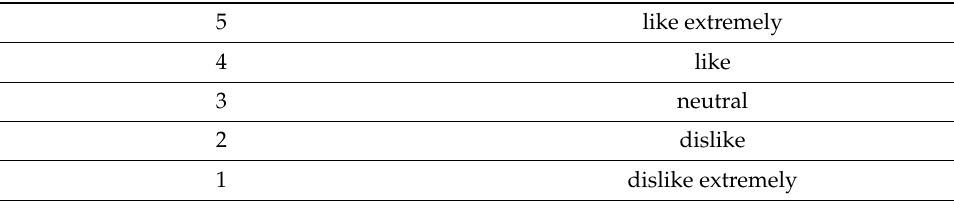
Table 5. Different dispensing formulations of